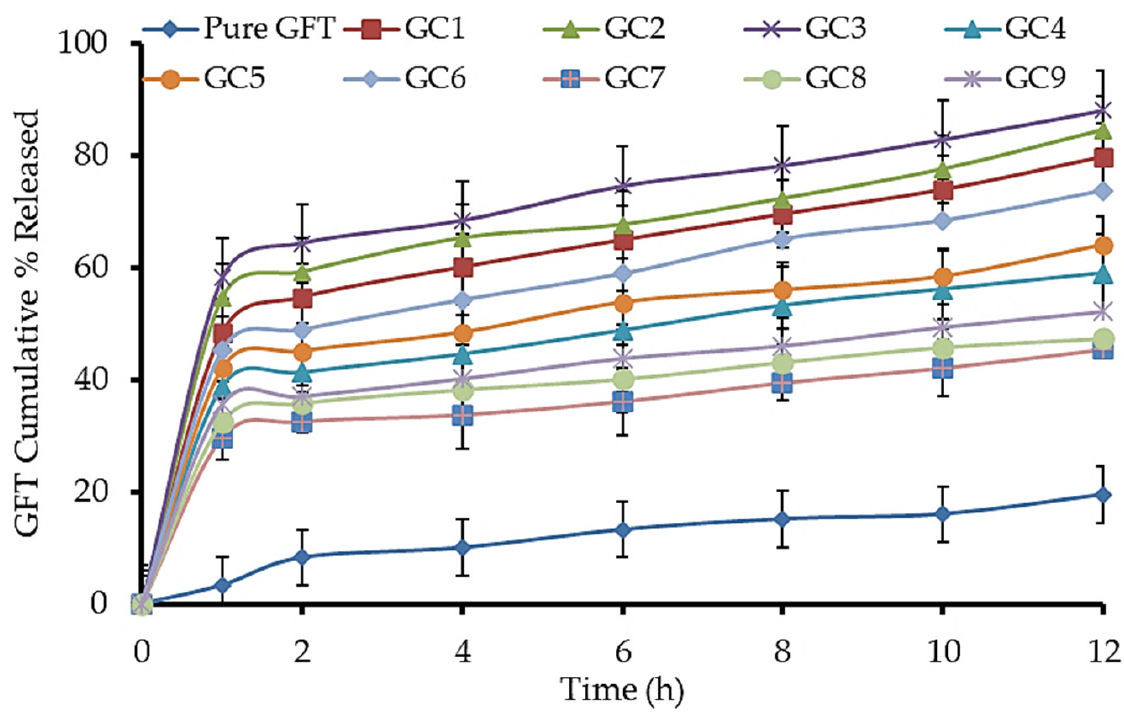
Figure 10. In vitro release profiles of pure GFT-suspension and GFT-CNP formulation (GC1–GC9) in phosphate buffer, pH7.4, at 37 ± 0.5 °C ( n = 3; the data are expressed as mean ±SD).